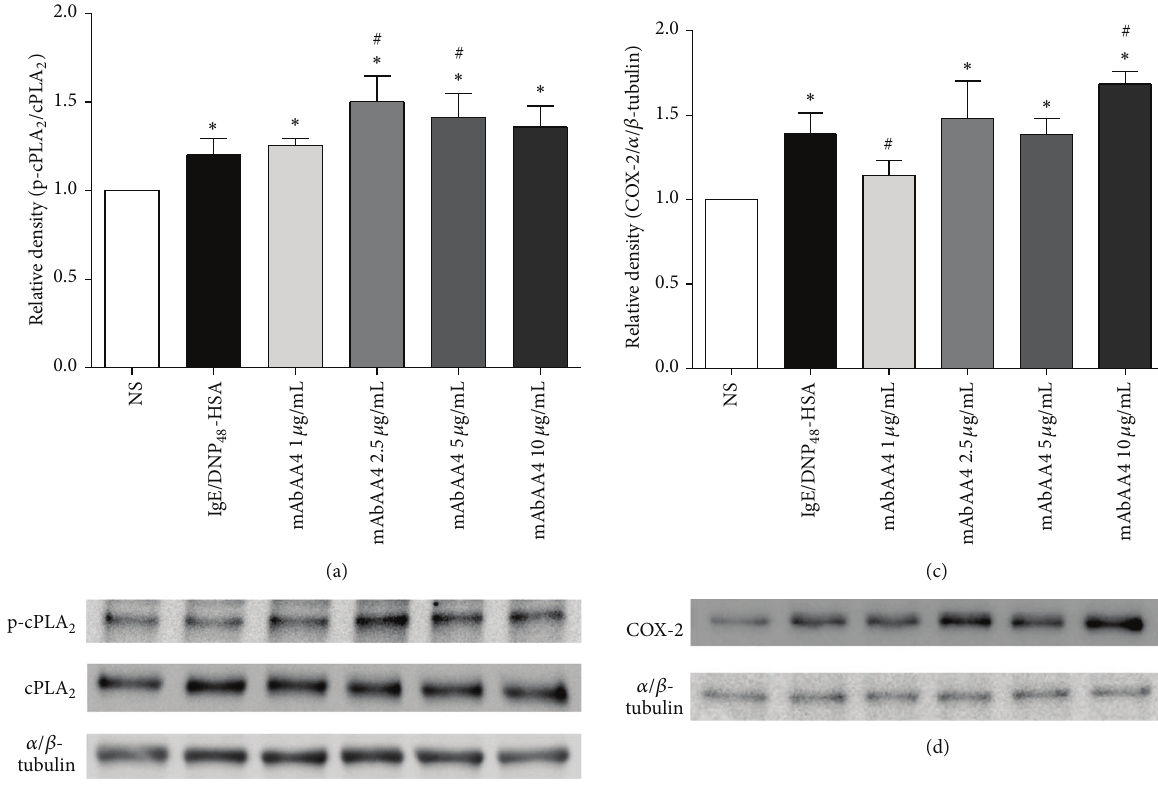
Figure 2: Cross-linking GD1b derived gangliosides by mAbAA4 increased cPLA 2 phosphorylation and induced COX-2 expression. Either RBL-2H3 mast cells were stimulated via Fc 𝜀 RI, by sensitizing the cells with IgE anti-TNP and stimulating with DNP 48 -HSA (50ng/mL), or cells were incubated with mAbAA4 (1, 2.5, 5, and 10 𝜇 g/mL) for 5min (cPLA 2 phosphorylation) or for 1h and then rinsed and cultured for an additional 3 h (COX-2 expression). Total cell lysates were immunoblotted with antibodies against p-cPLA 2 , cPLA 2 , COX-2, and 𝛼 / 𝛽 - tubulin (housekeeping protein) and the mean optical density of the bands was determined. Densitometry of the changes in expression and phosphorylation of proteins were corrected for 𝛼 / 𝛽 -tubulin. Data were expressed as the fold of nonstimulated (NS) cells. (a) Ratio of phosphorylated cPLA 2 /total cPLA 2 ; (b) a representative blot from (a); (c) ratio of COX-2/ 𝛼 / 𝛽 -tubulin; (d) a representative blot from (c). Data is expressed as the mean ± SD of three independent experiments. ∗ 𝑃 < 0.05 between experimental samples and the nonstimulated (NS) cells. # 𝑃 < 0.05 between experimental samples and Fc 𝜀 RI stimulated